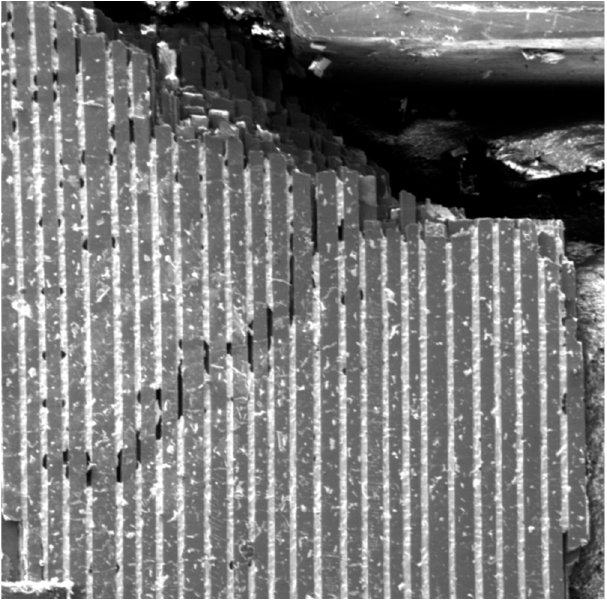
Figure 7. Fracture zone in front of the notch seen as a plane line at the right side. The same specimen as shown in Figure 3a; see also Table 1.